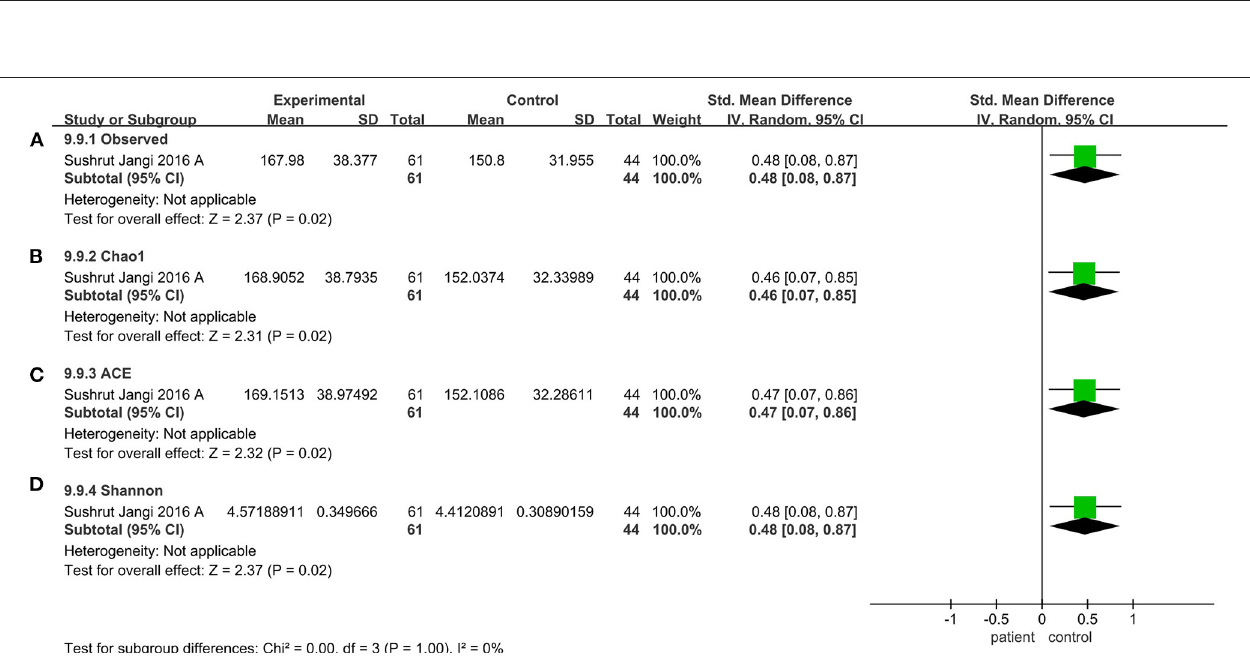
Frontiers in Neuroscience |